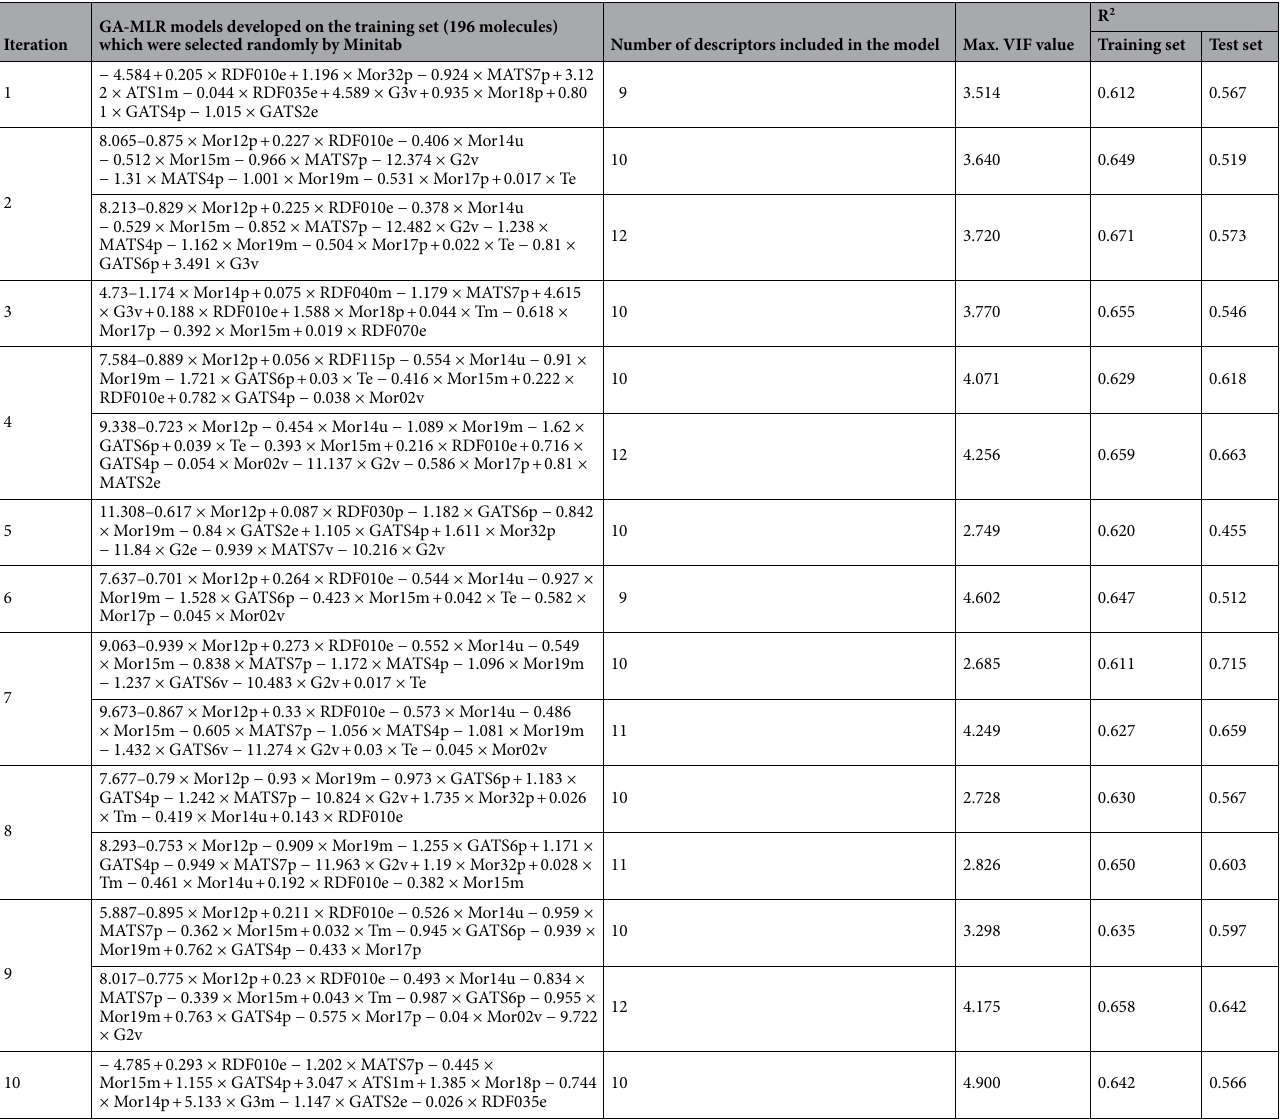
Table 7. Out-of-sample testing validation results based on the random dataset splitting.